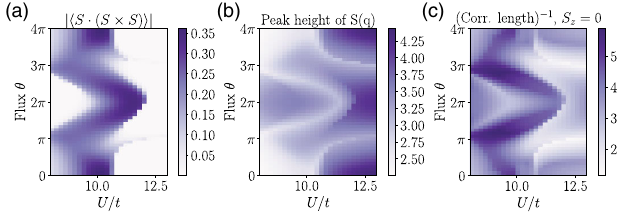
FIG. 6. YC4 cylinder with flux insertion θ , for χ ¼ 4000 . (a) Absolute value of chiral order parameter. The chiral phase exists for all twisted boundary conditions, but the phase boun- daries shift with θ . (b) Maximum of h S z S z i structure factor on allowed momentum cuts in the Brillouin zone. (c) Inverse correlation length for excitations with S z ¼ 0 , which serves as a proxy for the spin-singlet gap.